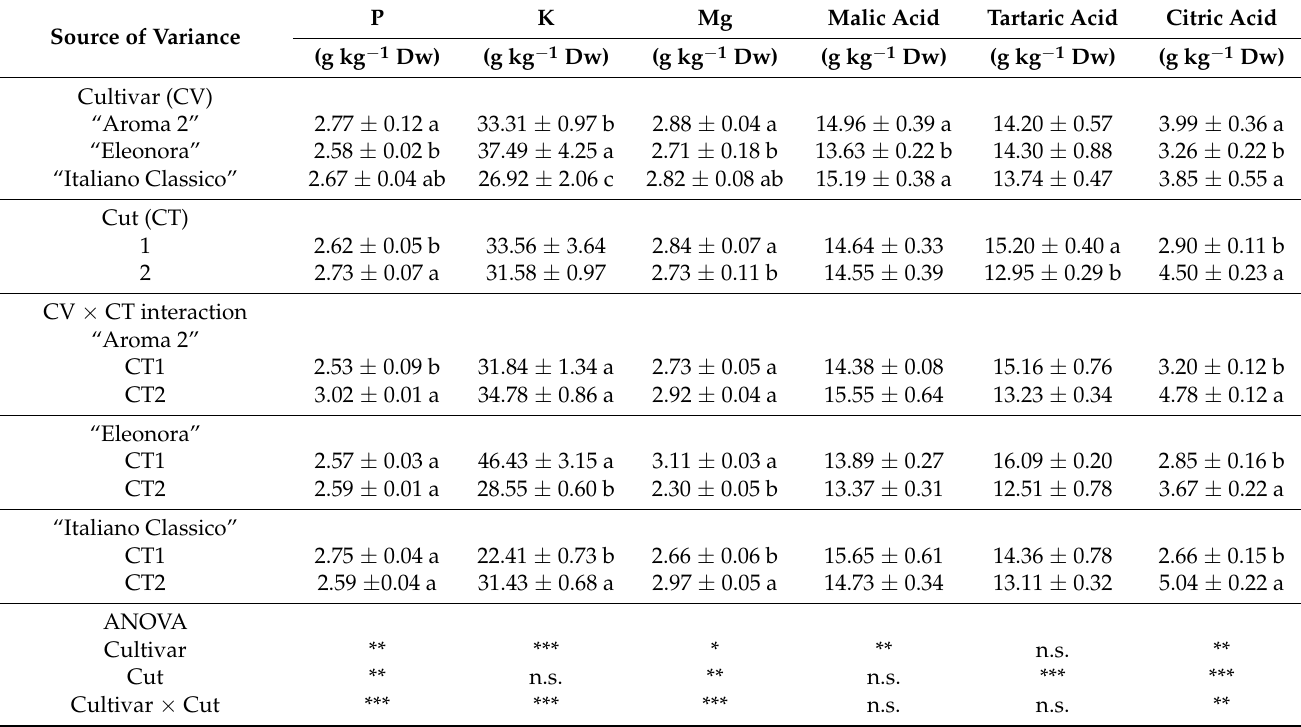
Table 4. Effect of cultivar and cut on minerals and organic acids accumulation of basil. Source of